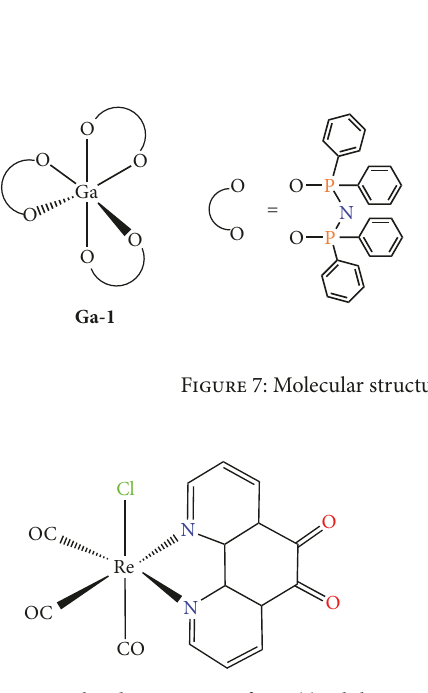
Figure 8: Molecular structure of a Re(I)